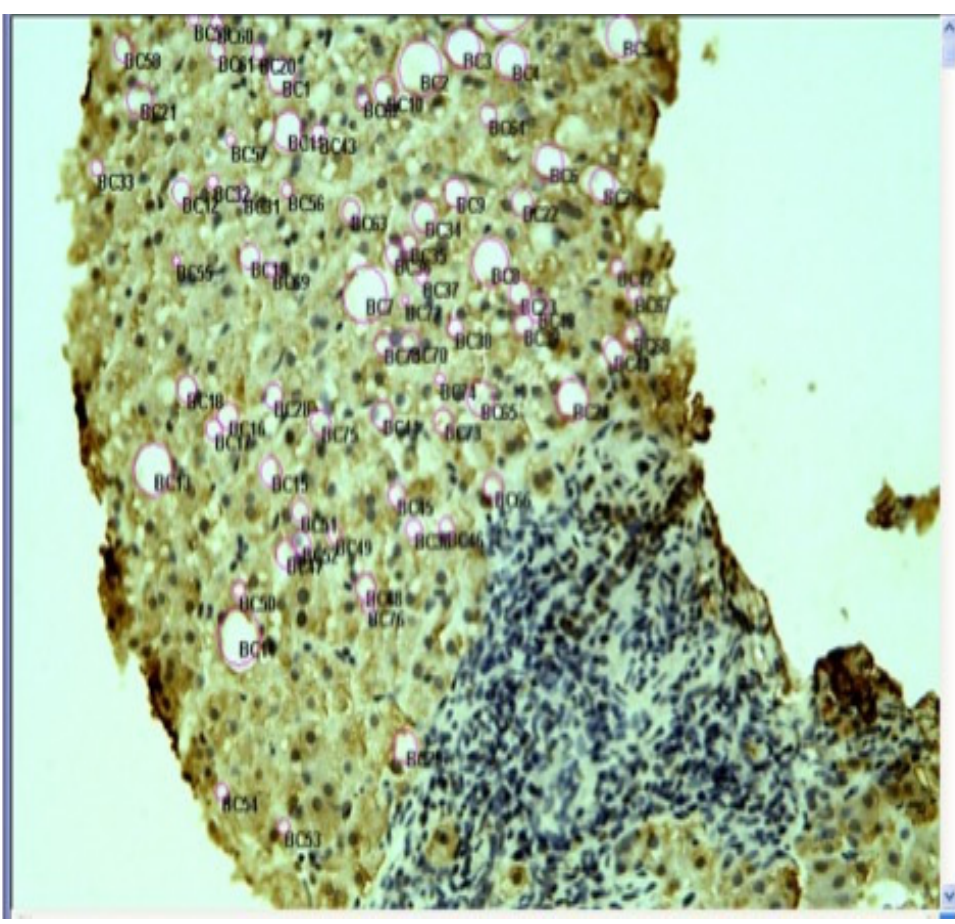
Figure 1. Liver biopsy from a patient with alcoholic liver disease. The biopsy shows hepatocytes with large lipid droplets (balloon cells—BC).